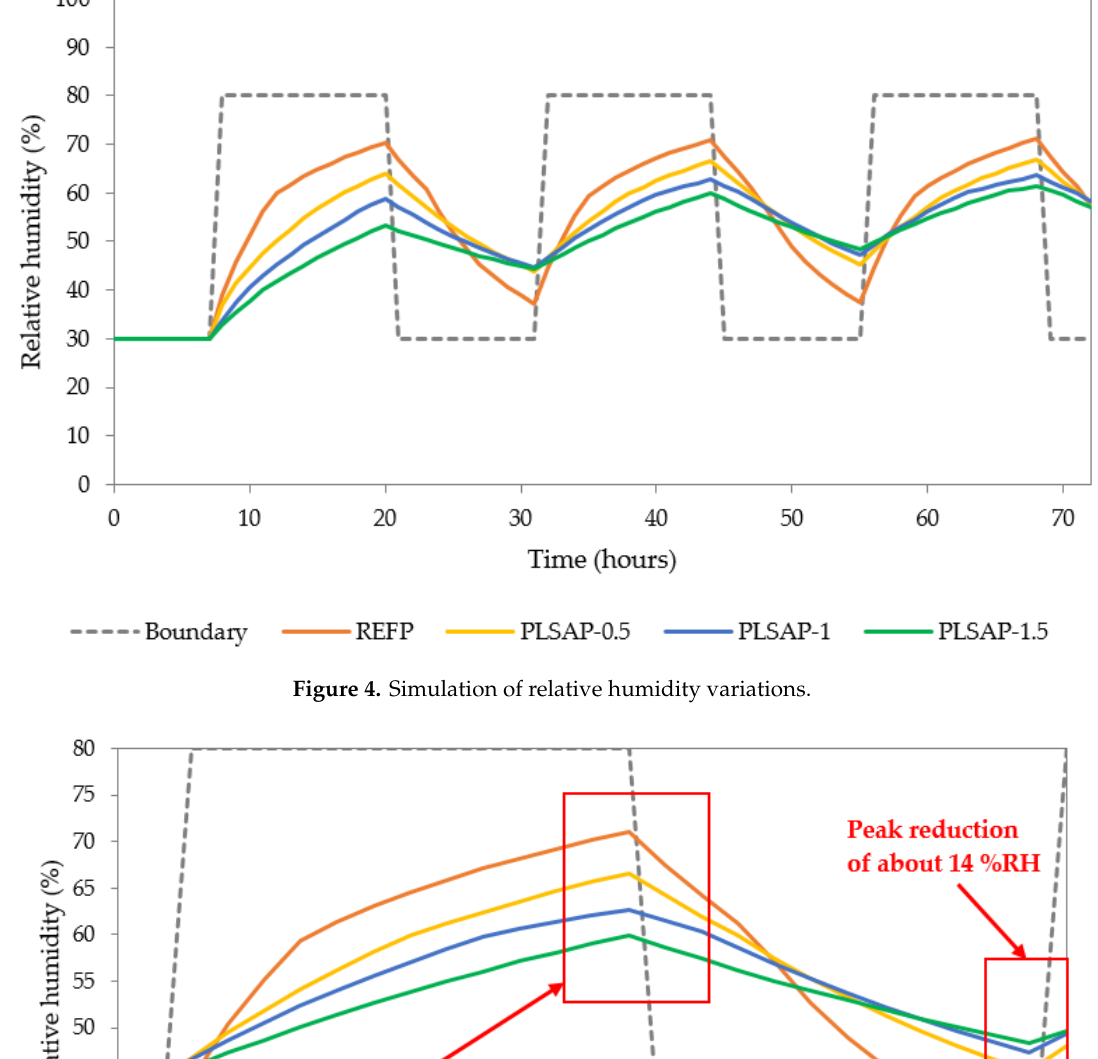
Figure 5. Detail of diurnal relative humidity variations.